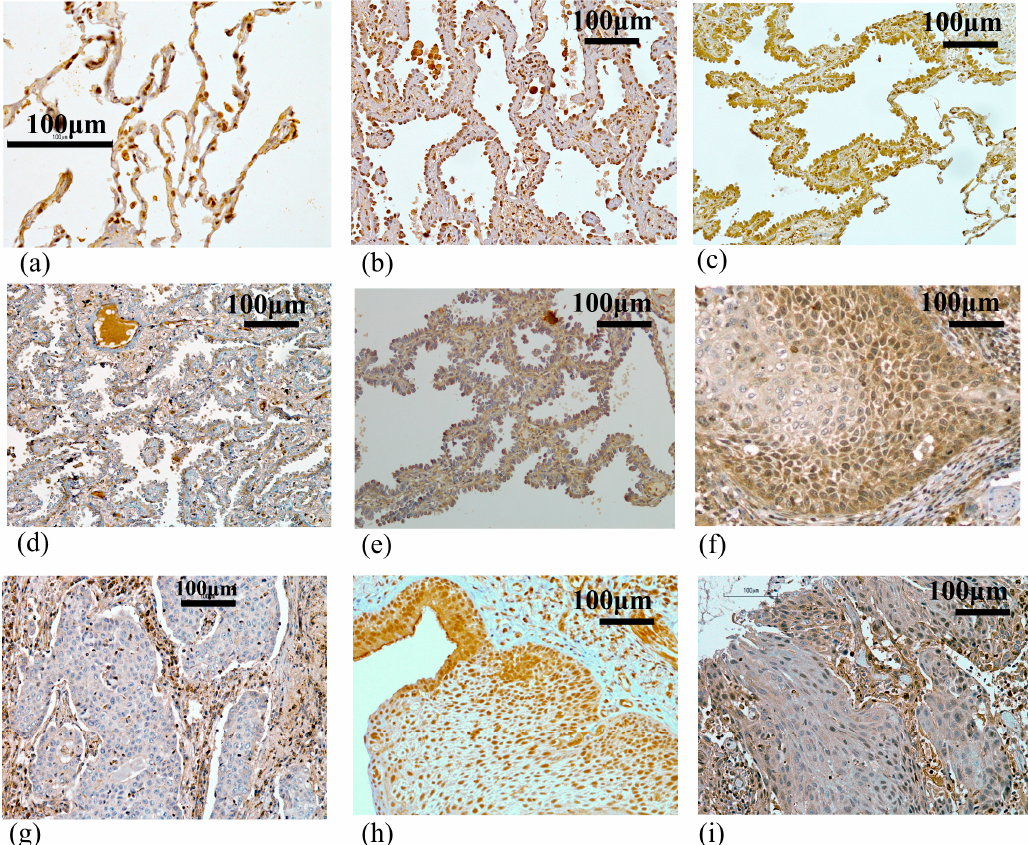
Figure 2. Immunochemical staining using the anti-BHLHE41 antibody. ( a ) Normal alveolar tissue (×400). ( b ) Positively stained case of adenocarcinoma in situ: p stage 0: TisN0M0. ( c ) Positively stained case of the lepidic growth part, and ( d ) negatively stained case of the invasive growth part in papillary adenocarcinoma (lepidic growth 40%): p stage IIIA: T4N1M0. ( e ) Negatively stained case of the lepidic growth part in papillary adenocarcinoma (lepidic growth 5%): p stage IIIA: T3N2M0. ( f ) Positively stained case of squamous cell carcinoma: p stage IA: T1aN0M0. ( g ) Negatively stained case of squamous cell carcinoma: p stage IA: T1aN0M0. ( h ) Positively stained case of early squamous cell carcinoma: DI:2. ( i ) Negatively stained case of early squamous cell carcinoma: DI:5. All pictures were taken at a magnification of 200 × (except for A: × 400); scale bar, 100 µ